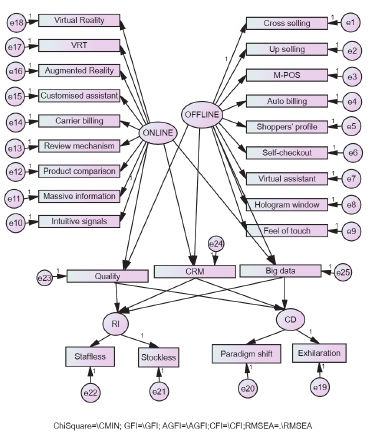
Fig. 2. Measurement model for Usage of AI technologies in Retail user Interface